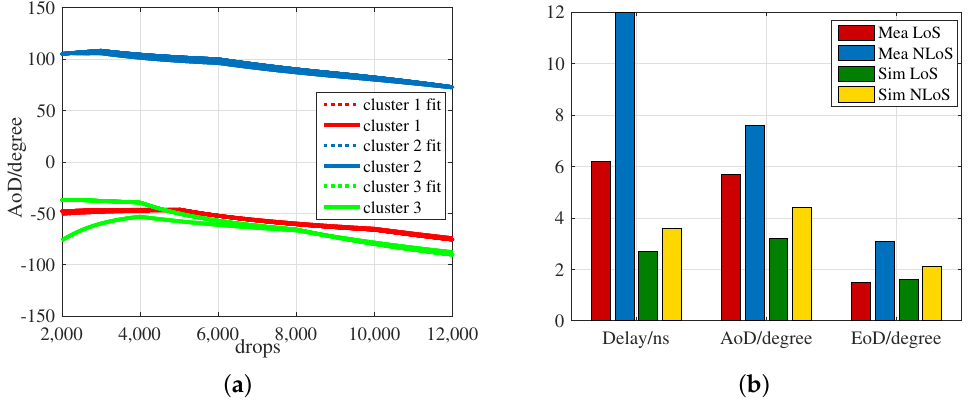
Figure 8. Profiles of GBDT-based model. ( a ) AoD example of degree of fitting. ( b )